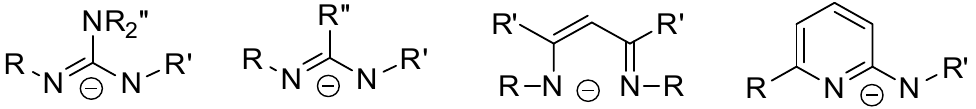
Figure 1. Guanidinate ligands (left) and other related bidentate monoanionic N-Ligands (R, R’ and R’’, for instance, alkyl or aryl substituents).